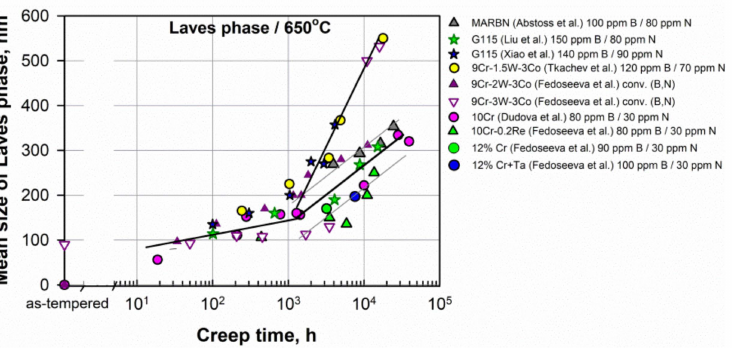
Figure 24. Evolution of the mean size of Laves phase particles during creep in the 9–12% Cr steels. Data from [8,16,17,21,22,27,38,39,49,71].